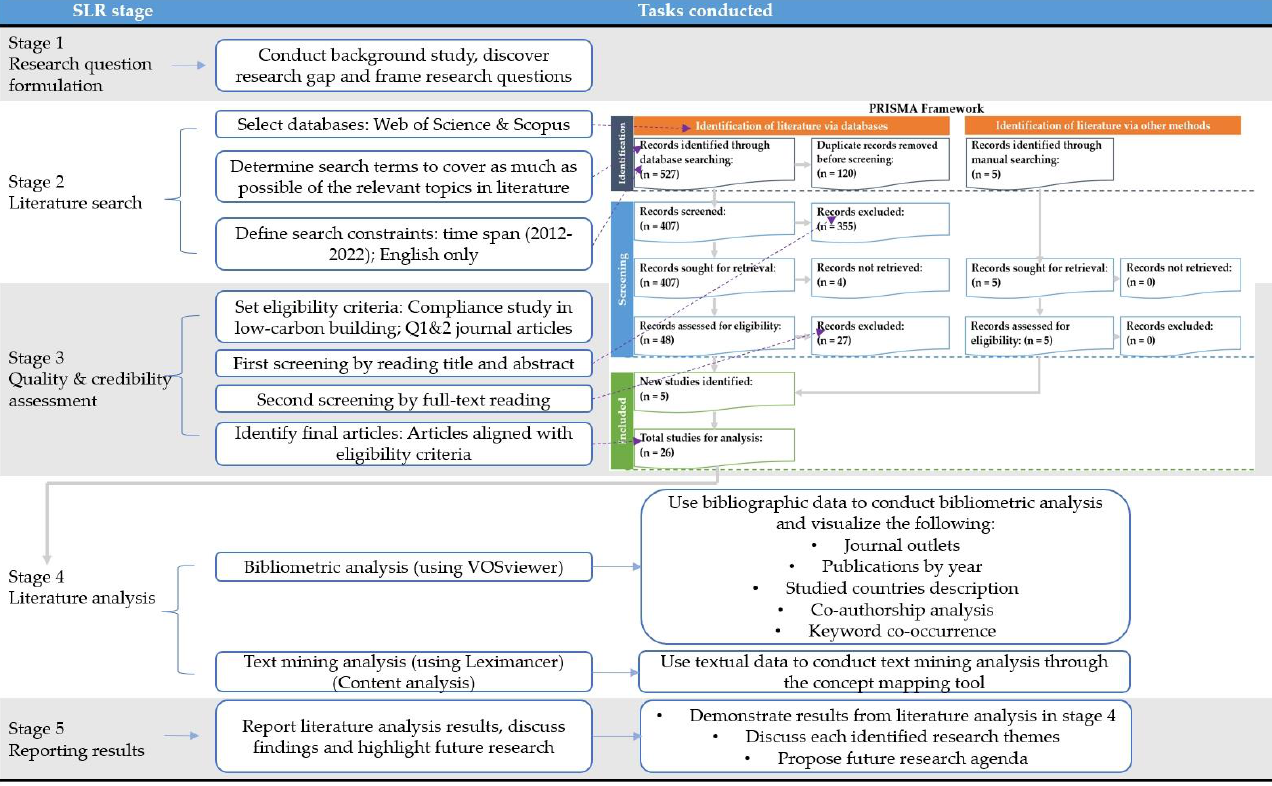
Figure 1. Five-stage SLR methodology following PRISMA framework, adapted from [18 – 20].